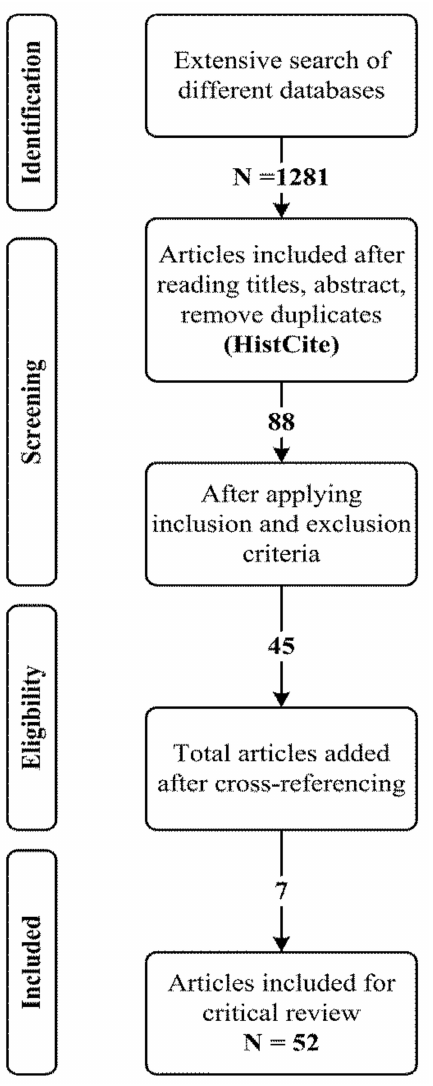
Figure 1. Stages of the literature search process. Table 3. Inclusion and exclusion